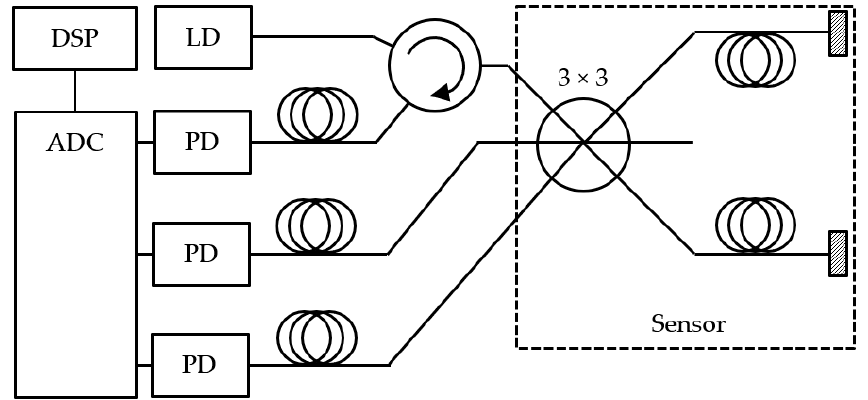
Figure 2. Proposed system connection diagram.